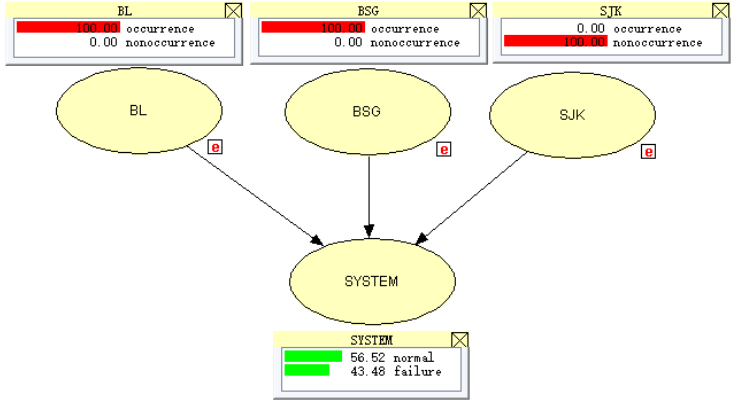
Figure 24. The cascade system failure probability of failure path 3.